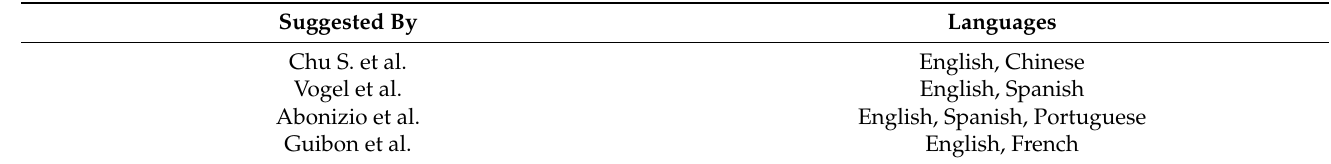
Table 10. Languages Per Cross-Language Methodology.